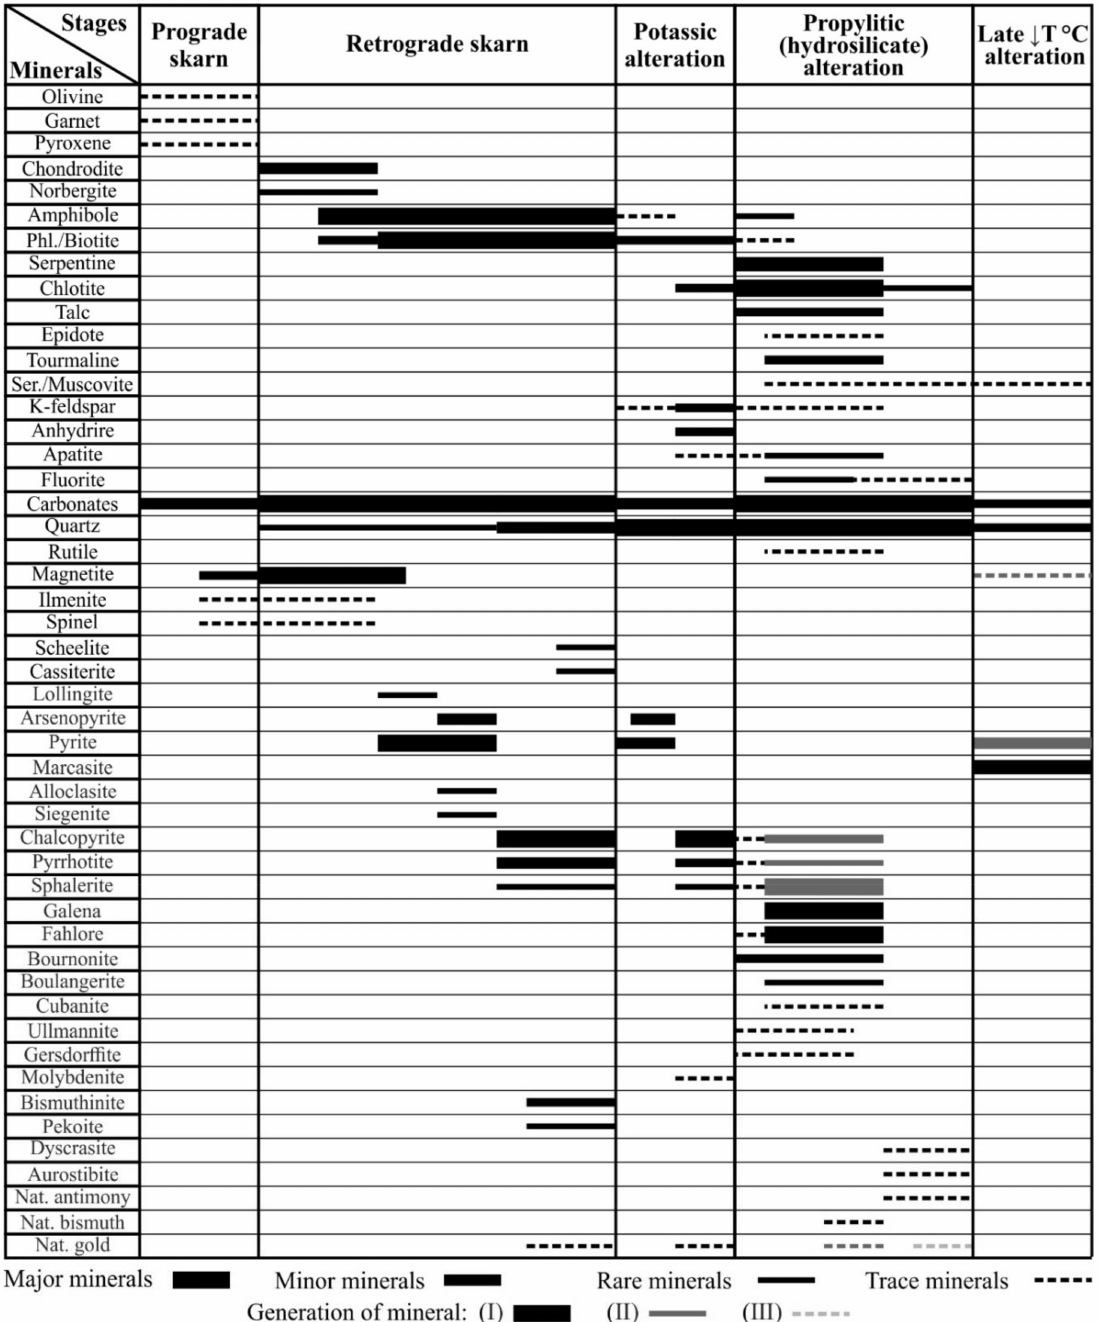
Figure 22. Paragenetic sequence of minerals and sequence of hydrothermal alteration assemblages at the Kultuma